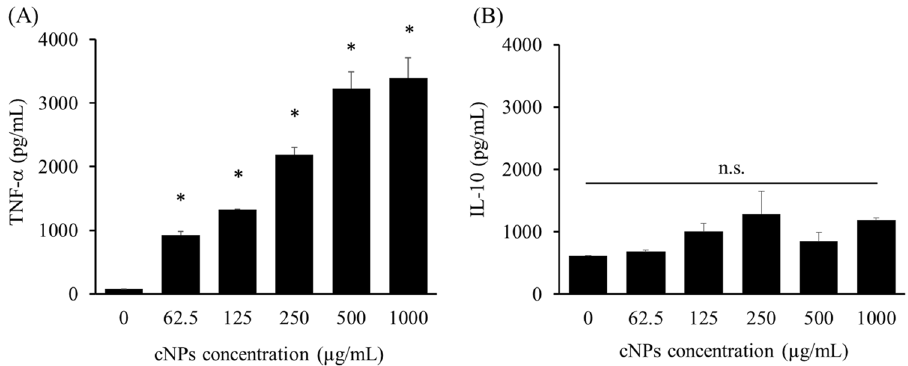
Figure 5. Cytokine release from RAW264.7 cells. (A) TNF-α and (B) IL-10 production from RAW264.7 cells after cNP addition. The supernatants of RAW264.7 cells after 24 h of cNP addition were collected for ELISA. Results are expressed as the mean ± SD of three samples. *p < 0.05 vs. 0 μg/mL cNP group (the control group). n.s. not significant.